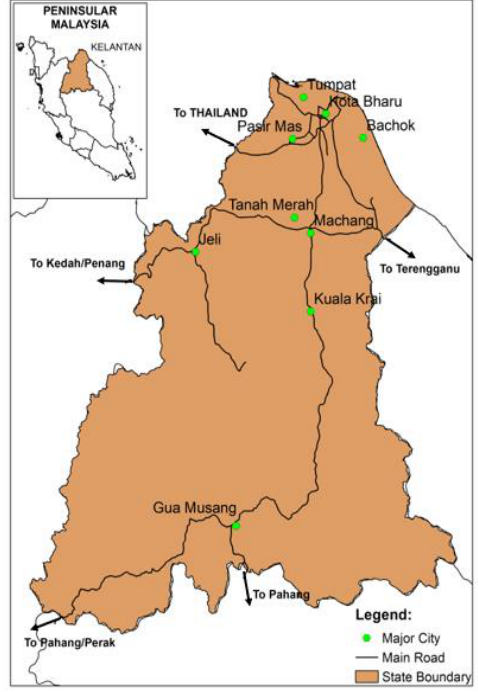
Figure 1. The Study